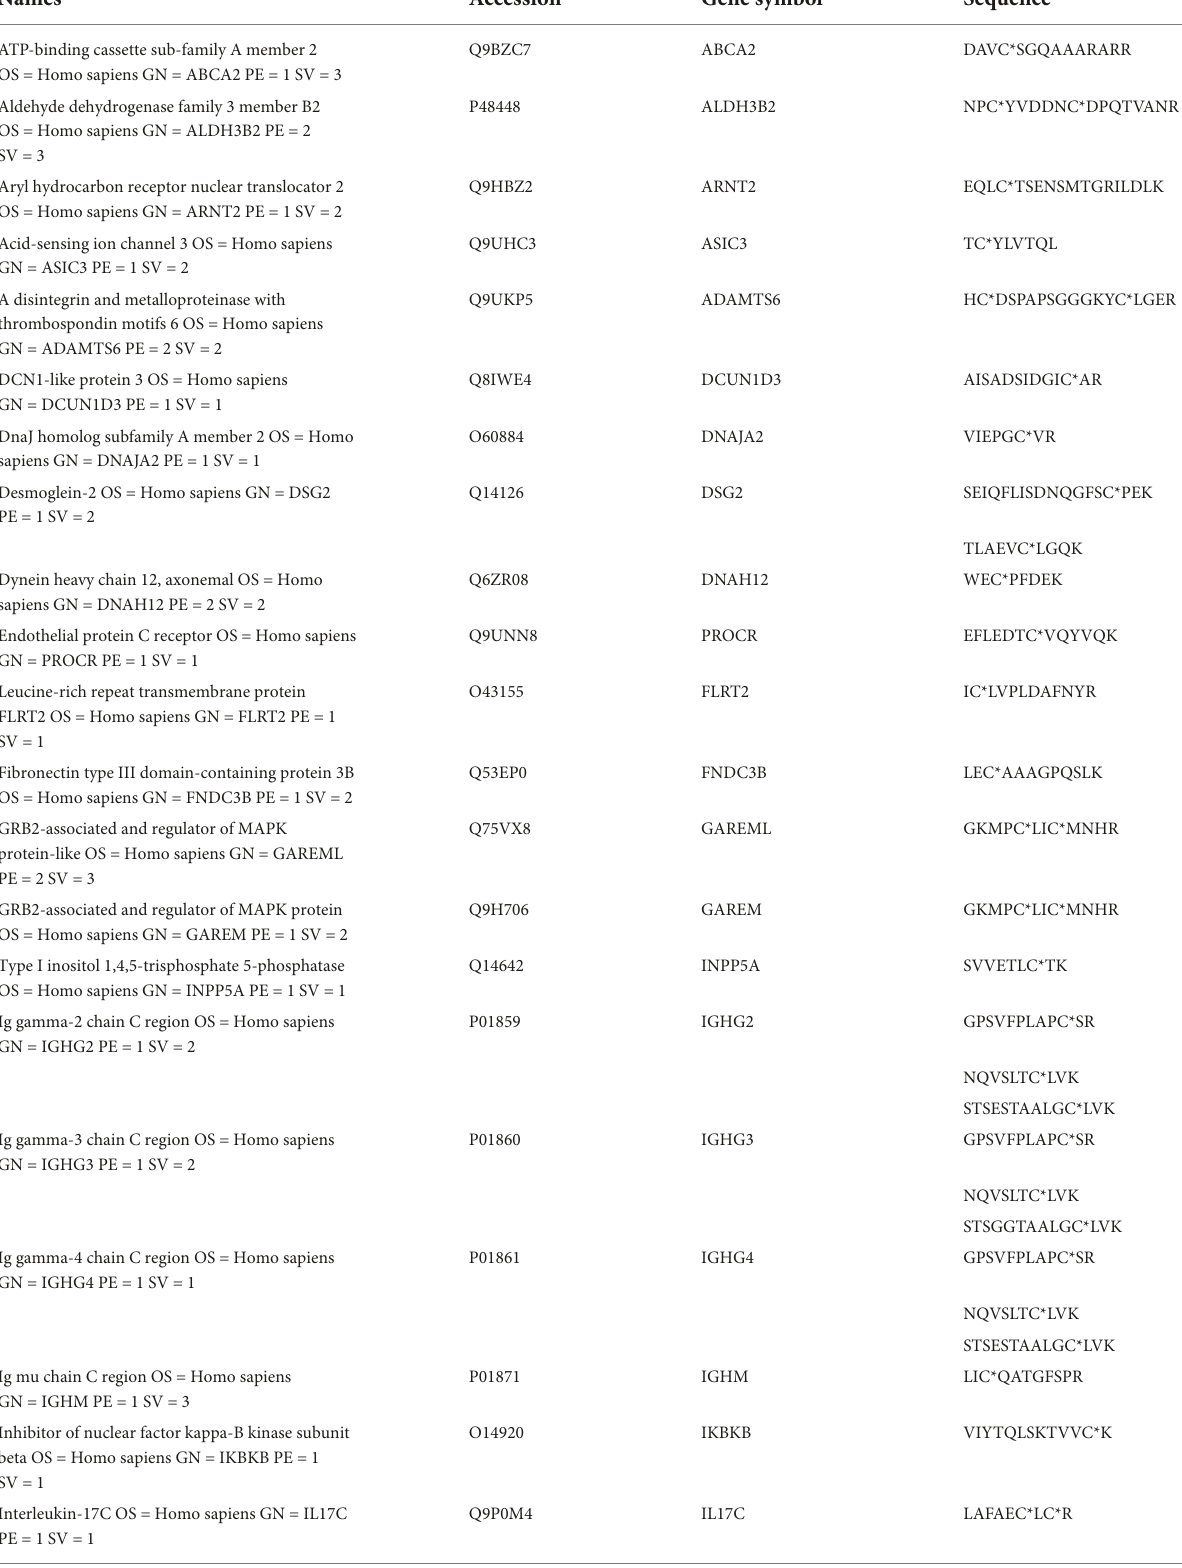
TABLE 1 The list of potentially palmitoylated proteins and peptides identified in this